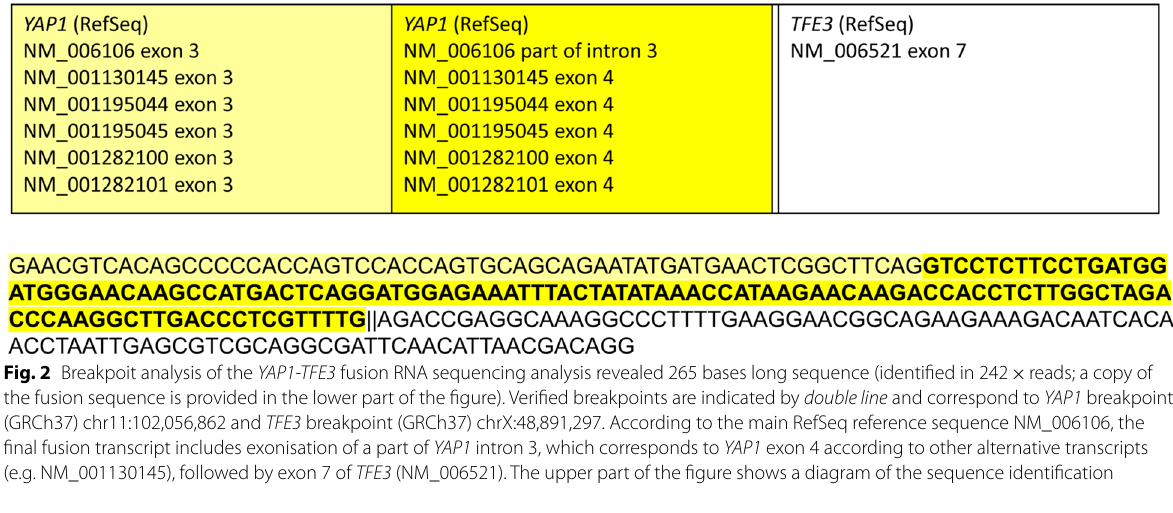
reads; a copy of ×